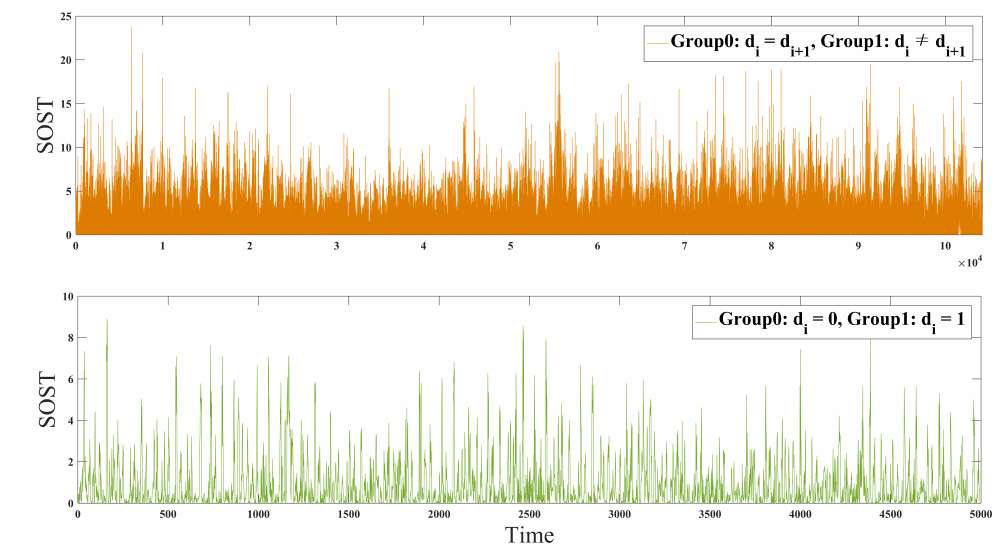
Figure 14. SOST value of countermeasure: hardware implementations ( top ) and software implementations ( bottom